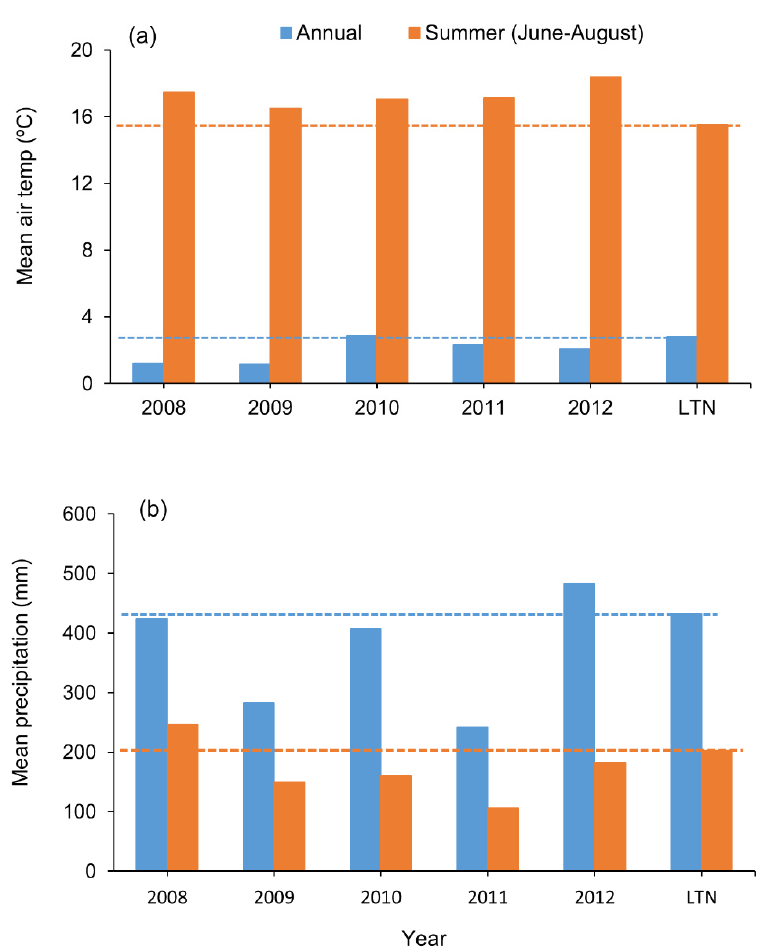
Figure 2. Annual and summer (June–August) ( a ) ambient temperature and ( b ) precipitation from years 1 to 5 at the research sites. LTN = long-term average 1980–2010. Dotted lines indicate the long-term mean of 1980–2010.